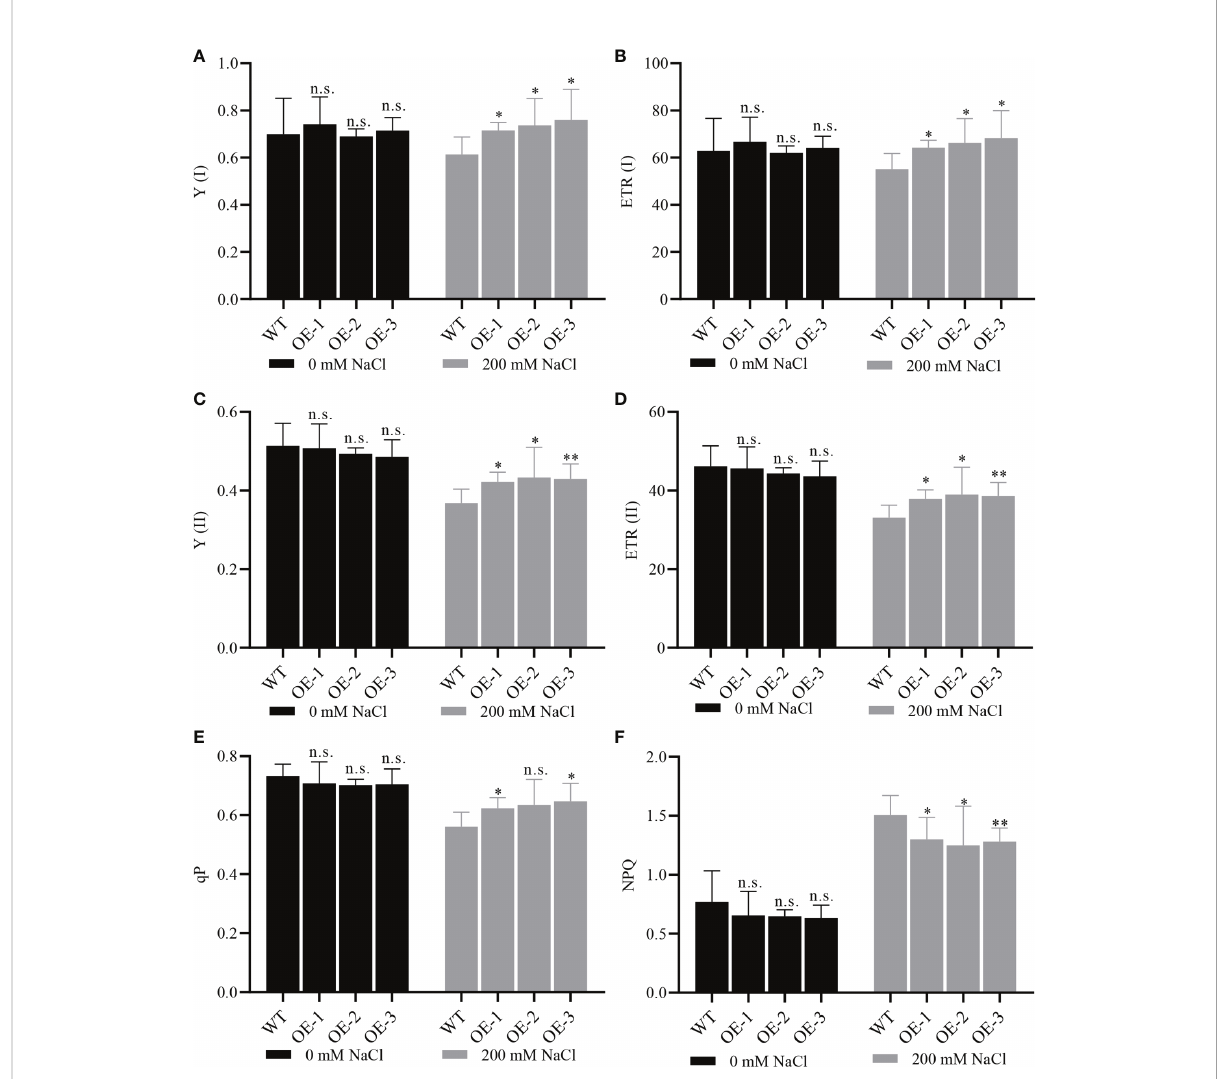
FIGURE 9 NbCIPK25 affects photosynthesis under salt treatment. (A – F) Photosystem I (PSI) photochemistry, Y (I); electron transport rate of PSI, ETR(I); photosystem II (PSII) photochemistry, Y (II); electron transport rate of PSII, ETR(II); Photochemical quenching, qP; Non-photochemical quenching, NPQ, under the treatment and genotypes as indicated. WT mean wild type Col Arabidopsis . OE-1, 2, 3 represent three independent NbCIPK25 transgenic lines. Data represent means ± SD from three biological replicates, t-test used for statistical analysis, ‘ * ’ p < 0.05, ‘ ** ’ p < 0.01, n.s., not signi fi